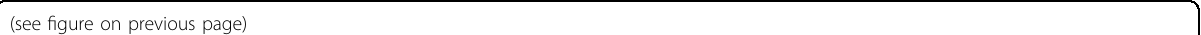
Fig. 1 PolyQ toxicity in C. elegans is reduced upon AMP-activated protein kinase (AMPK) activation and requires lysosome function. a Metformin was able to reduce aggregation in a dose-dependent manner in 1-day-old adult worms expressing 40Q::YFP in muscle cells. Treatment with metformin signi fi cantly rescued aggregates in a dose-dependent manner ( p < 0.001). b Metformin required aak-2 /AMPK α and lysosome function to reduce the number of inclusion bodies in L4 larvae. Larvae were used to test for AMPK function because the difference between mutant and wild-type worms is reduced as the animals age (data not shown). Treatment with metformin rescued aggregates in 40Q animals ( p < 0.001). Chloroquine maintained high levels of inclusion bodies even when the 40Q worms are treated with metformin ( p < 0.001). Metformin required aak-2 / AMPK to partially rescue polyQ aggregation ( p < 0.001). c Photographs of wild-type and aak-2 /AMPK α mutant L4 larvae expressing 40Q::YFP in muscle cells treated with or without 2 mM metformin and/or 10 μ M chloroquine. Larvae were used to test for AMPK function because the difference between mutant and wild-type worms is reduced as the animals age (data not shown). d Treatment with metformin signi fi cantly rescued neuronal function (assessed by the touch response; see Materials and methods) in 112Q-TdTomato worms ( p < 0.001). The metformin-induced rescue of neuronal function required lysosomal function: chloroquine treatment reduced neuronal recovery even when the worms were treated with metformin ( p = 0.261). e Worms require AMPK α activity to rescue the neuronal function induced by metformin. Metformin was applied to worms expressing 112Q-TdTomato in mechanosensory neurons in an aak-2 background. The touch response was assessed as above. Metformin required aak-2 /AMPK to rescue neuronal function ( p = 0.634). In all cases, values are the mean, and bars indicate the con fi dence interval (95%